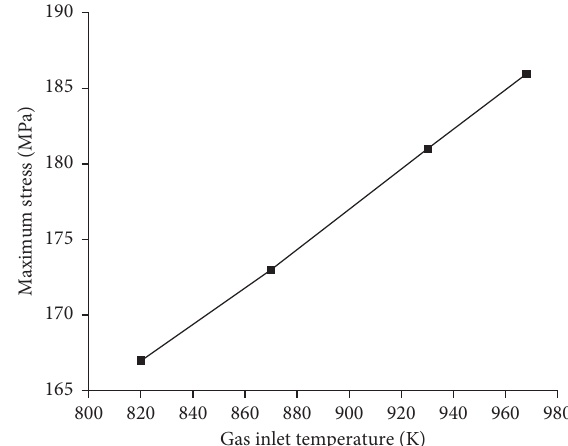
Figure 17: Maximum stress varies with temperature when gas inlet temperature is changed.